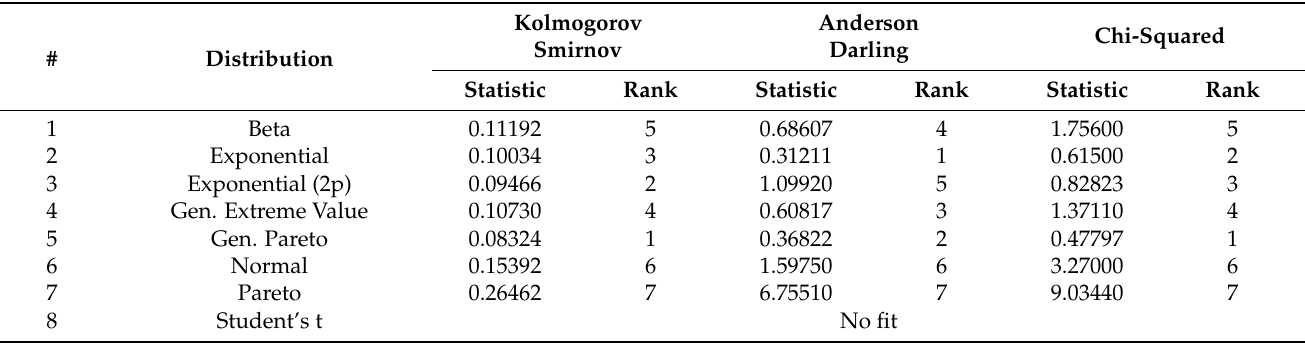
Table 1. Plotting results of rice yield return data.